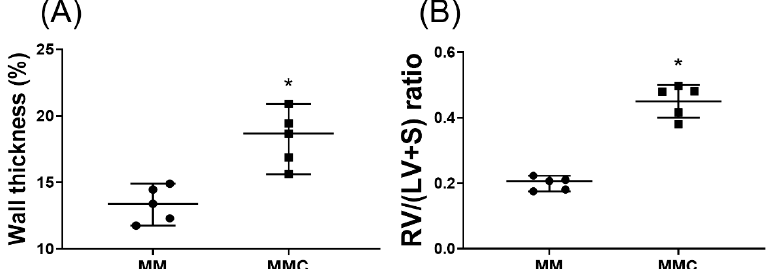
Figure 8. Calcium chloride counteracts the e ff ects of magnesium sulfate (MgSO 4 ) in monocrotaline- treated rats. ( A ) Wall thickness ratio of the pulmonary arteries. ( B ) Weight ratio of right ventricle to left ventricle plus septum [RV / (LV + S)]. MM: monocrotaline (60 mg / kg) plus MgSO 4 (100 mg / kg / day) group. MMC: monocrotaline (60 mg / kg) plus MgSO 4 (100 mg / kg / day) plus calcium chloride (100 mg / kg / day) group. Data are expressed as median (range). Data of wall thickness ratio of pulmonary arteries and RV / (LV + S) were both obtained from five rats from each group, respectively. * p < 0.05 the MMC group versus MM group.